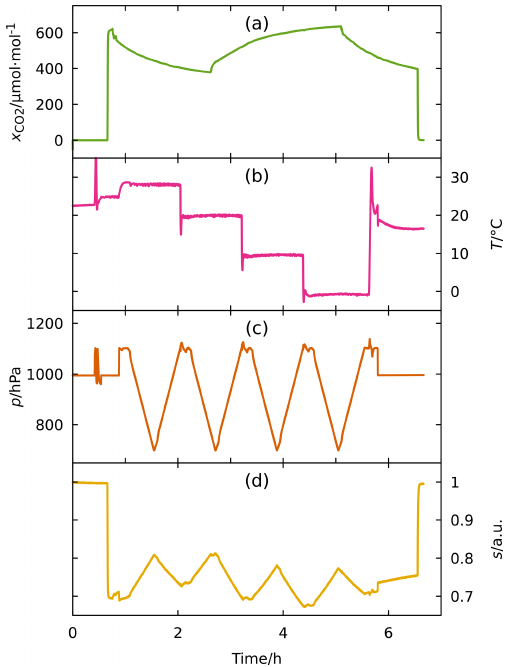
Figure 4. Conditions during one of the experiments carried out to define a calibration curve for the CO 2 sensor: (a) CO 2 dry air mole fraction x CO measured with a reference analyser, (b) ambient tem- 2 perature T , and (c) ambient pressure p . (d) Normalised infrared signal s from the optical detector of COCAP’s CO 2 sensor. The variations in pressure influence the observed signal more strongly than the changes in x CO by 200µmolmol − 1 , which illustrates the 2 need for a precise pressure